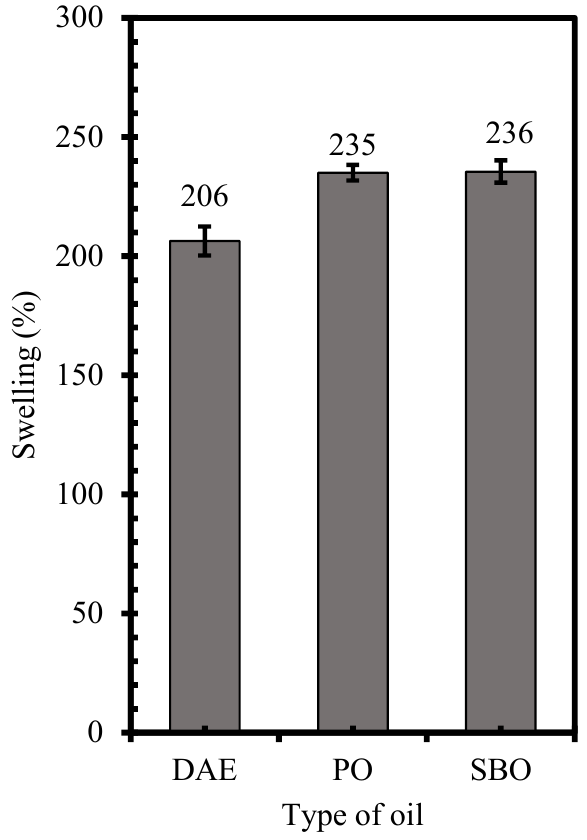
Figure 3. Percentage of swelling of NR in oil.